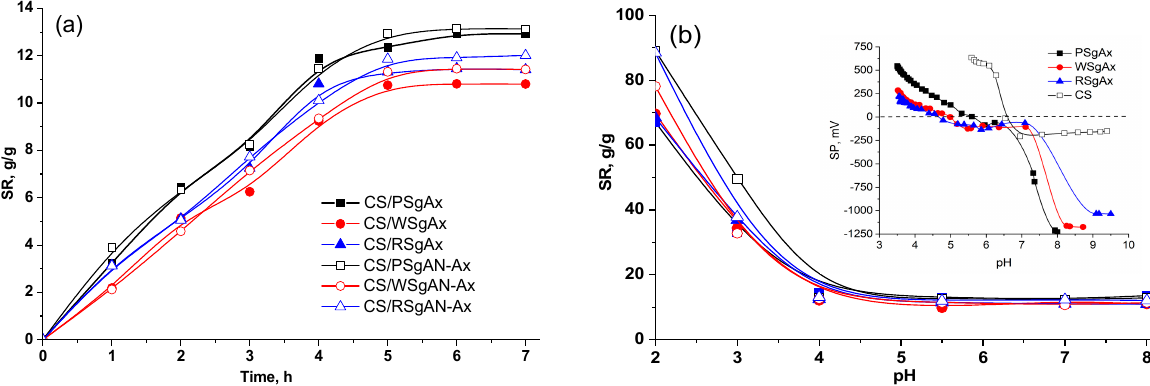
Figure 7. Swelling of the composite hydrogel beads as a function of time at pH = 6 ( a ) and different pH values ( b ); inset in ( b ) potentiometric titration curves of SgAx and CS.